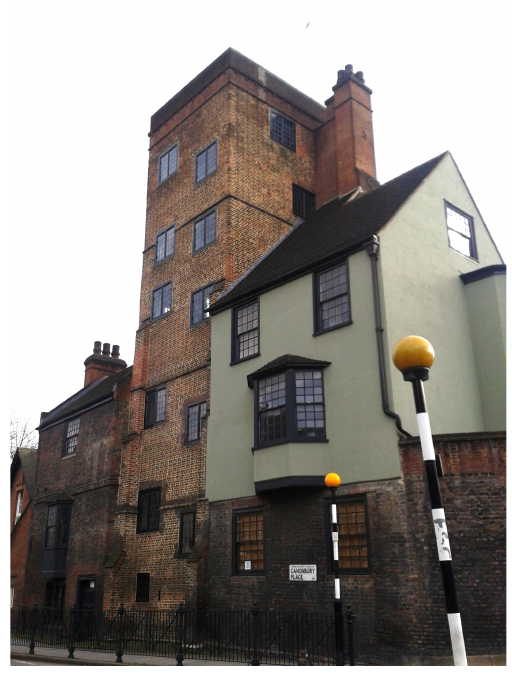
Fig. 1. Canonbury Tower, North London (photo: